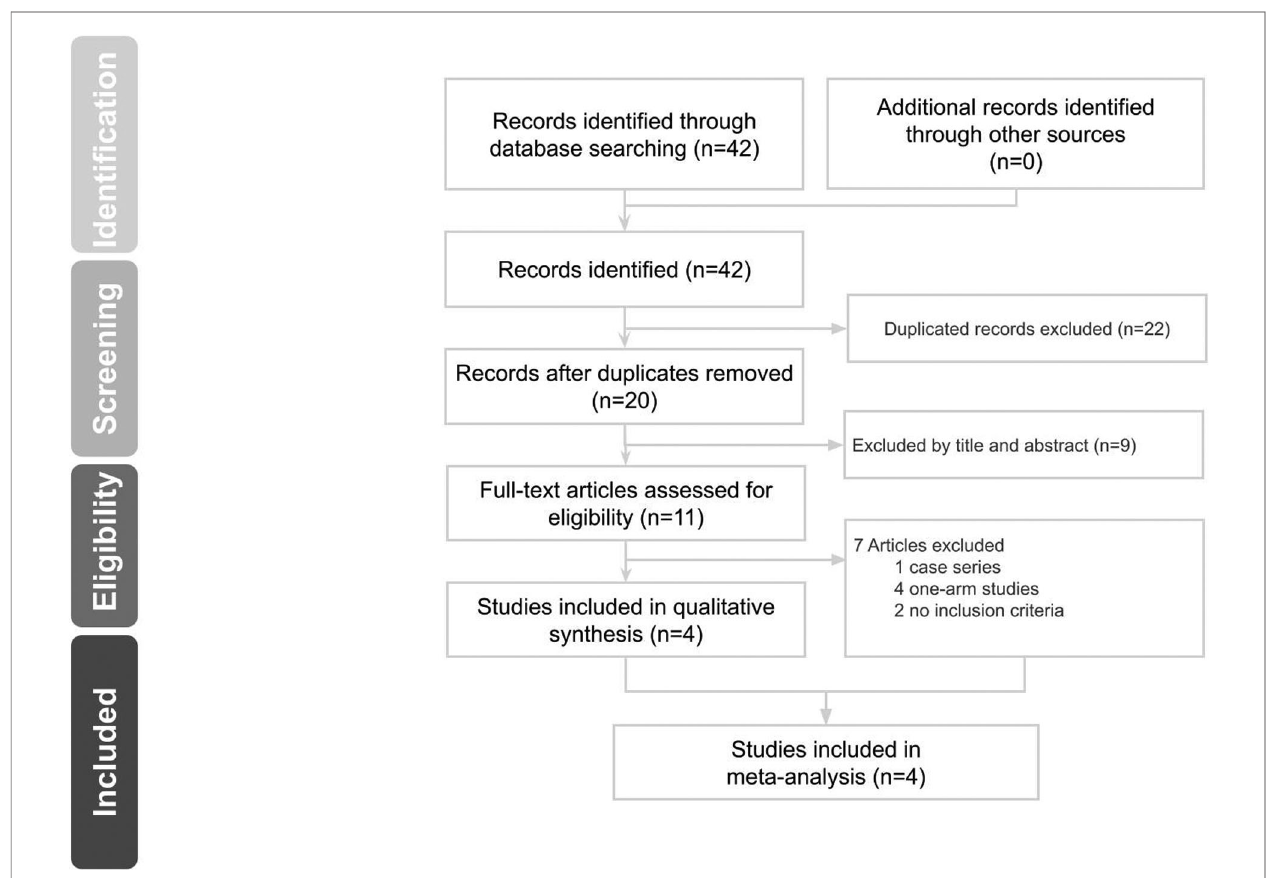
FIGURE 1 | PRISMA fl ow diagram of study